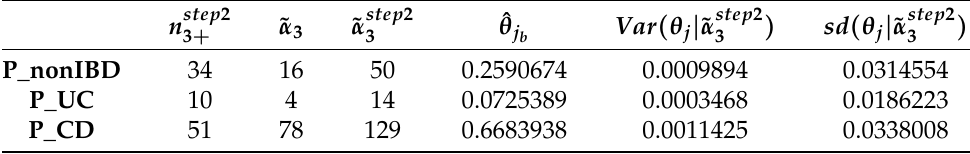
Table 33. Bayesian summaries Step 2 in A_CD